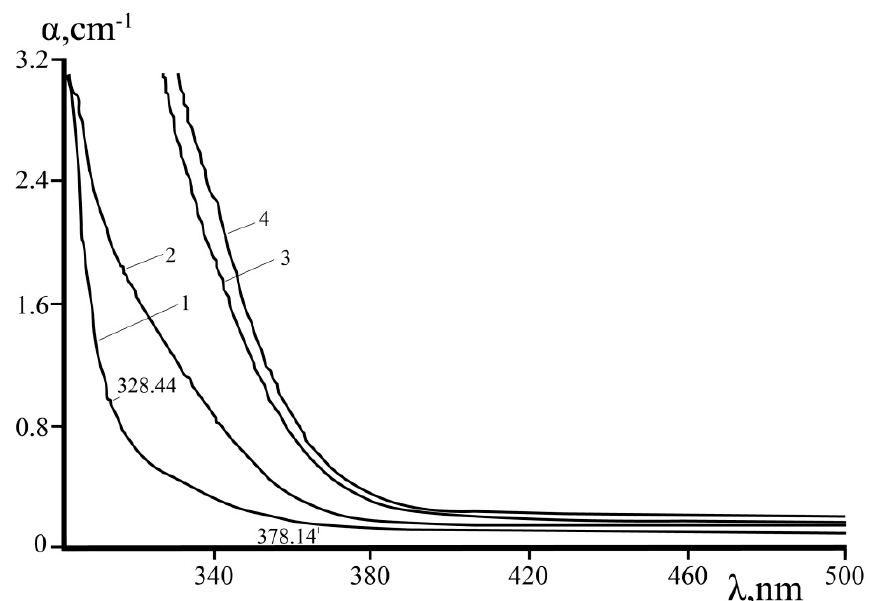
Figure 9. Absorption spectra of SLN (1), CLN (2) and LiNbO 3 :B (0.55 (3), 0.83 (4) mol%). The figure is reproduced with the permission of Pleiades Publishing from the paper N. V. Sidorov et al., Techn. Phys . 2020 V. 65 P. 627–634, DOI: https://doi.org/10.1134/S1063784220040192 (accessed on 26 March 2021).